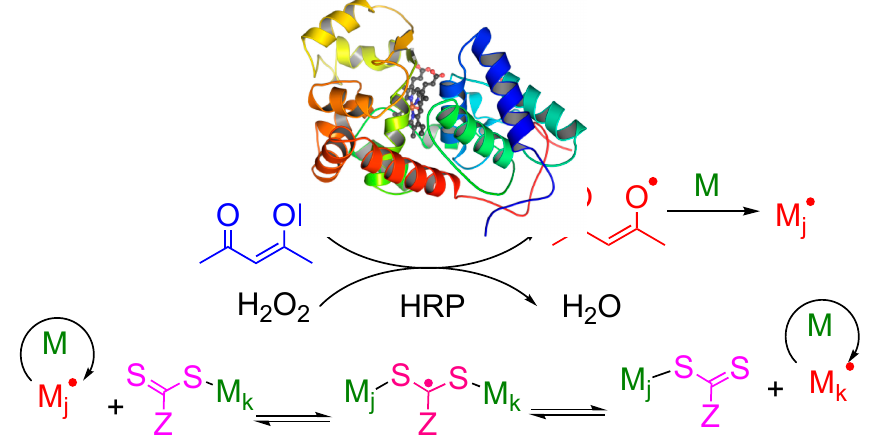
Scheme 1. Top: enzymatic carbon centered radical generation and initiation of polymerization, and bottom: RAFT equilibrium and degenerative transfer.